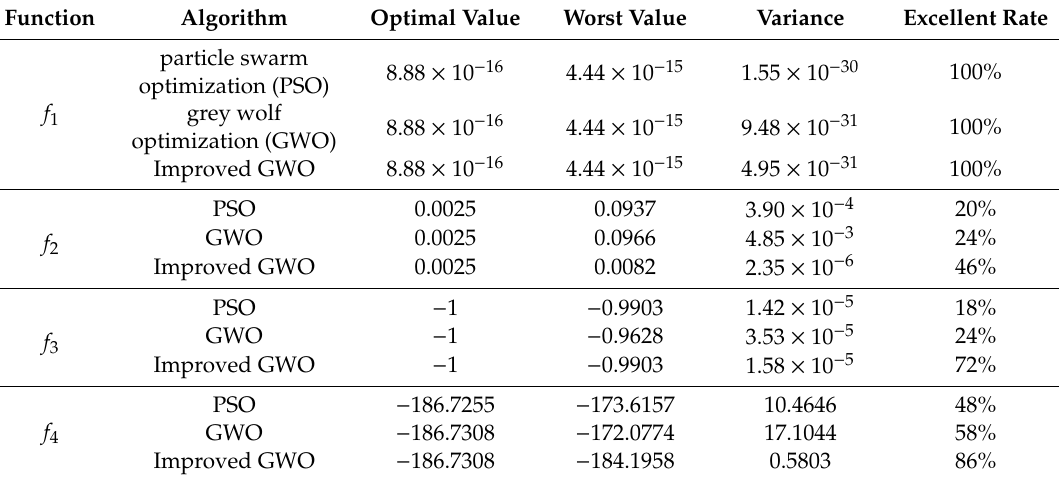
Table 2. Comparison of the three algorithms.